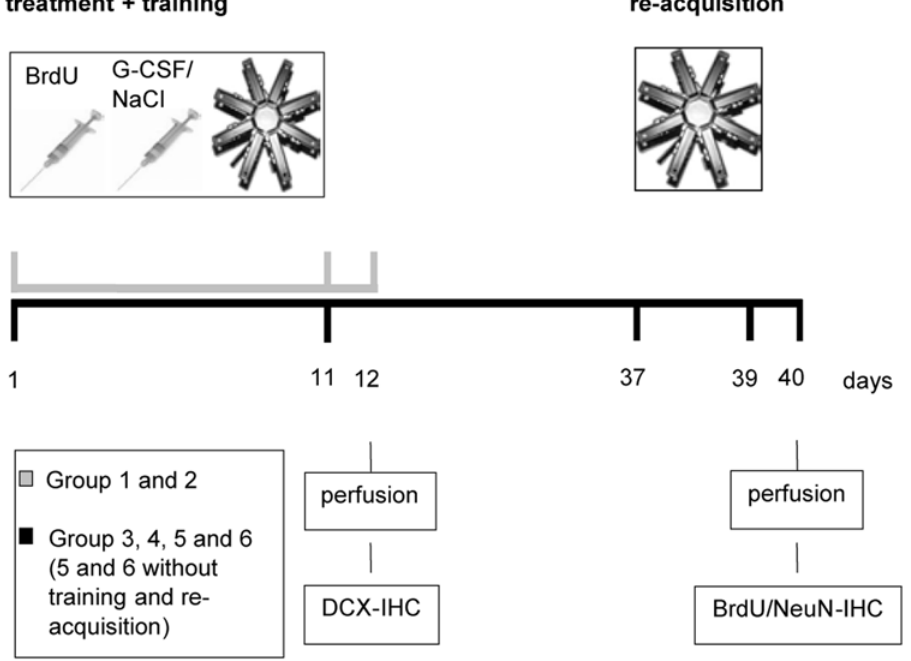
Figure 1. Experimental design showing the different interventions and points of measurement.